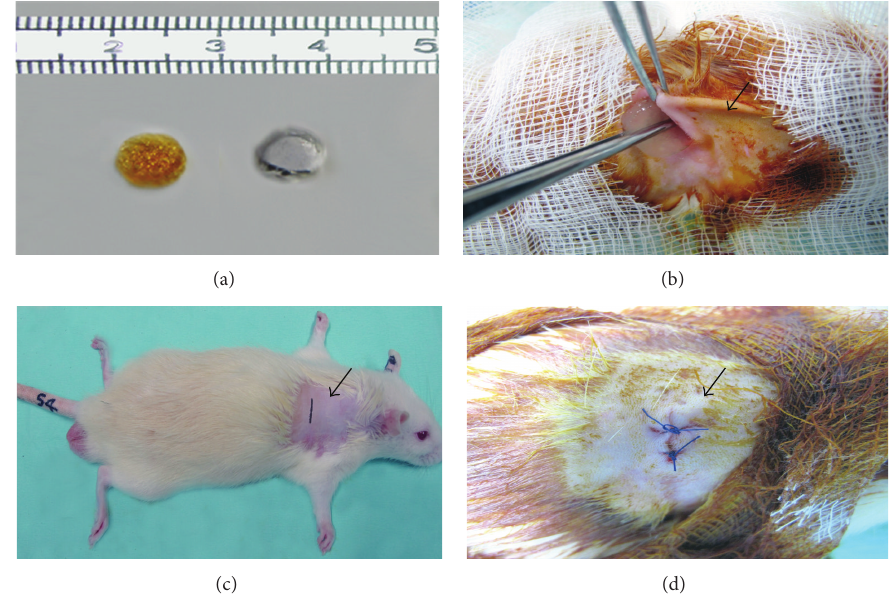
Figure 1: (a) Hydrogel and silicone discs. (b) The fur is cleared and marked incision area indicated by arrow. (c) Arrow indicates the representative animal and site of material implanted. (d) Representative photograph for site of implantation after suturing